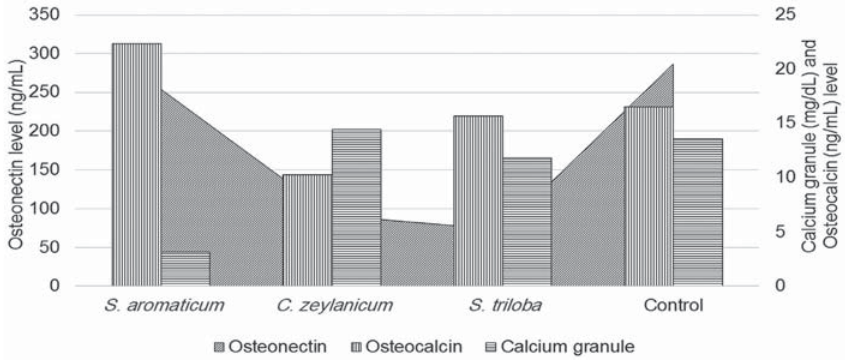
Figure 5- Calcium granule, osteocalcin, and osteonectin levels of dental pulp stem cells (DPSCs) treated with the Extracts